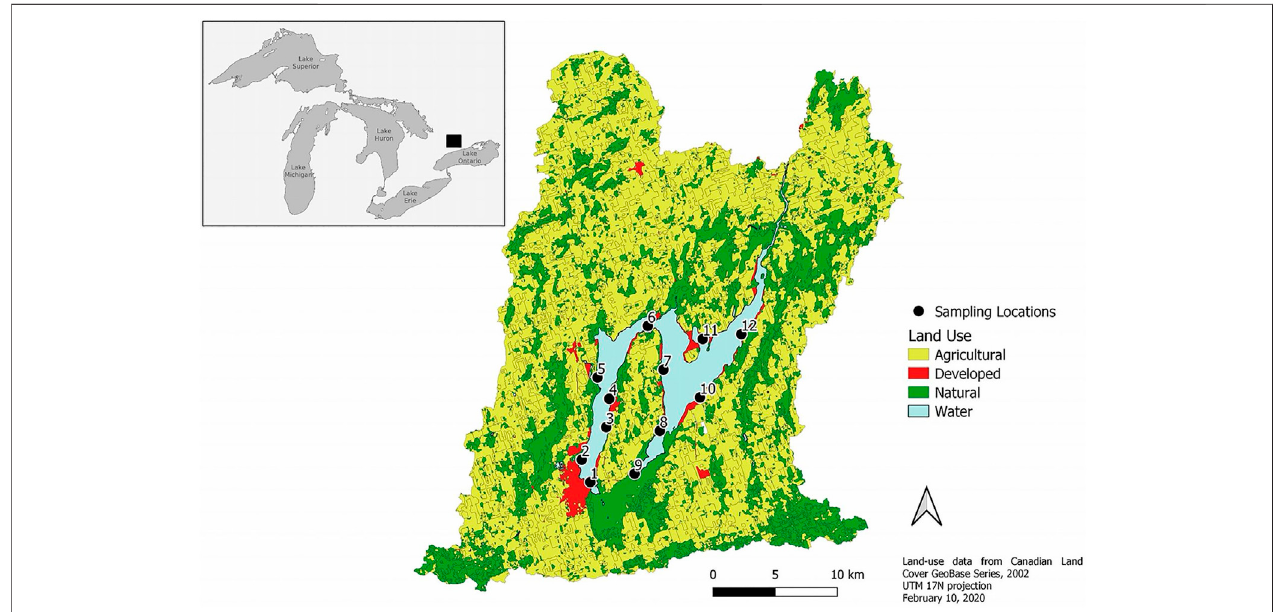
FIGURE 1 | Map of Lake Scugog, and sampling site locations, within the delineated watershed and land-use features. Sampling locations are labelled 1 – 12. This map was created in QGIS version 3.12.0 (QGIS Development Team, 2016).